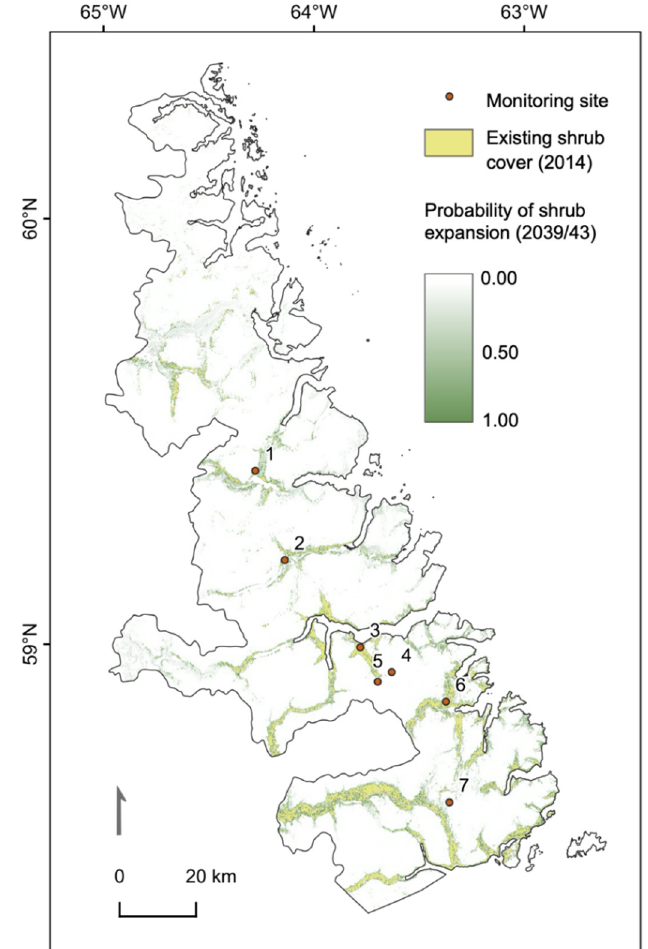
Figure 7. Extent of shrub class pixels in 2014 (time 2 ; yellow) and probability of pixels becoming shrub dominant by 2039/43 (time 3 ; green scale). Monitoring sites: 1—Kangalaksiorvik Lake; 2— Komaktorvik Falls; 3—Ivitak Cove; 4—Cirque Mtn. Camp; 5—Upper Ivitak Valley; 6—Ramah Bay; 7—Nakvak Brook.